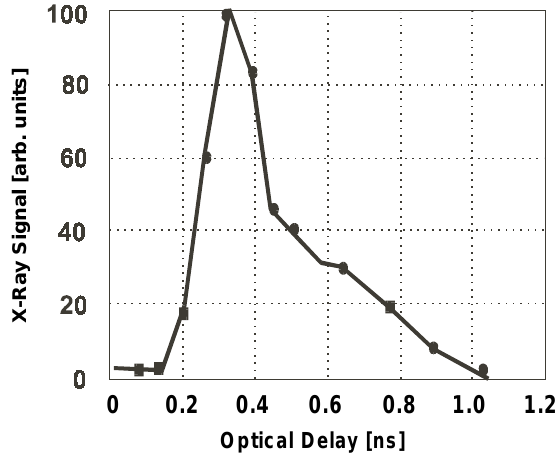
FIG. 9. Delay scan of the laser pulse.